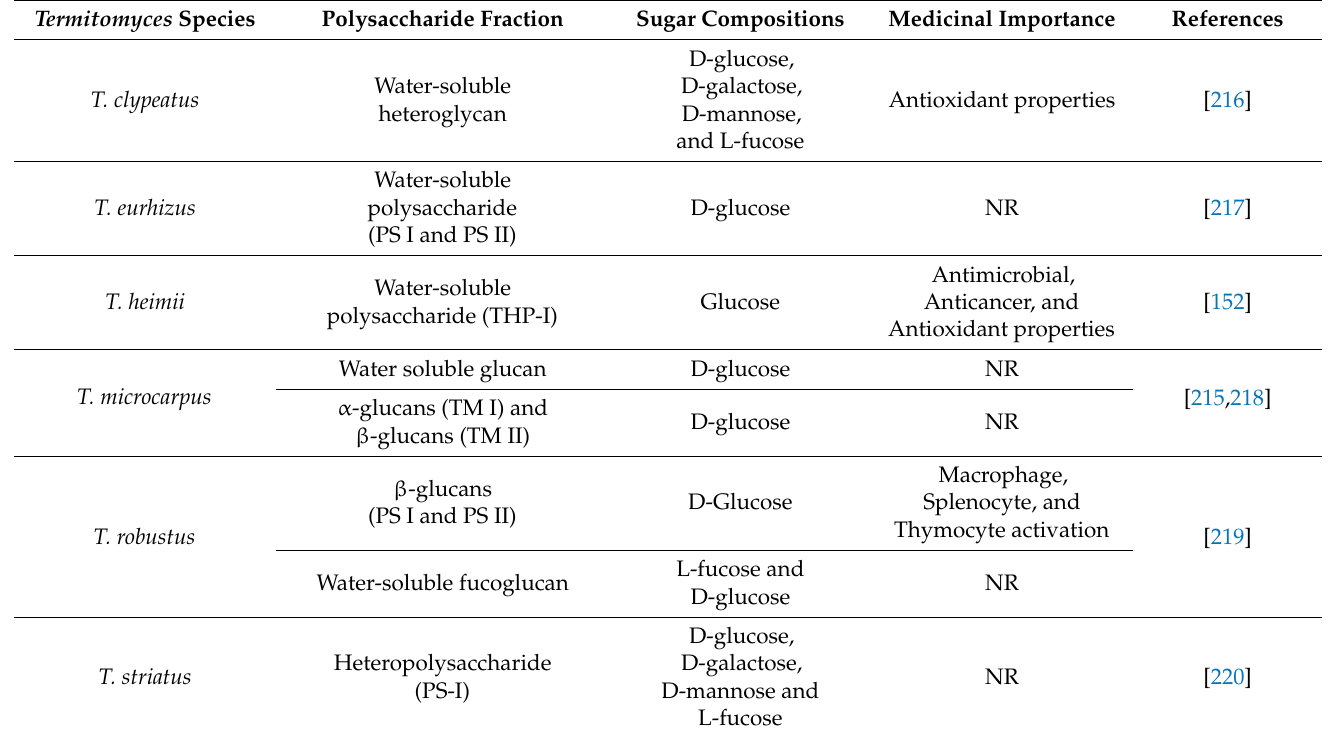
Table 5. Sugar compositions of polysaccharide from different Termitomyces